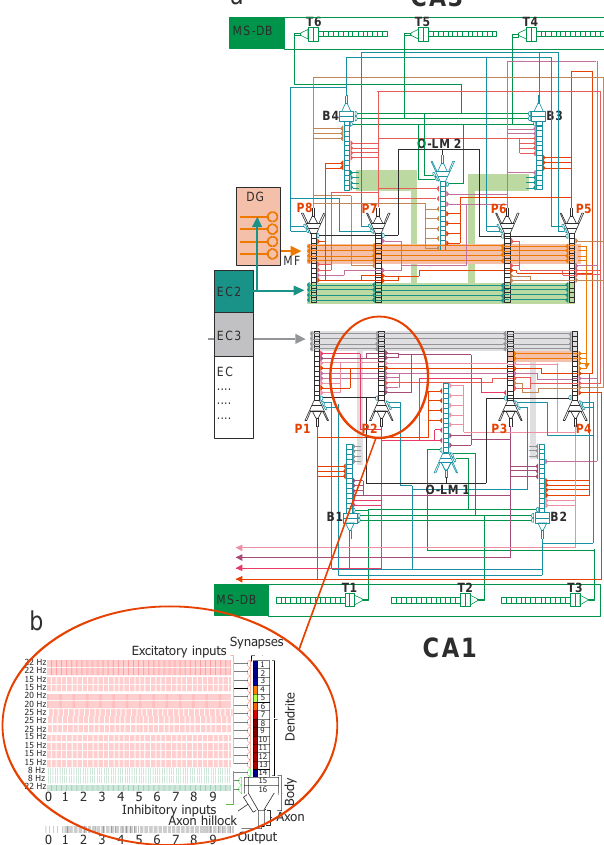
Figure 1. ( a ) The CA3-CA1 hippocampal formation microcircuit. On the top is the CA3 region and CA1 is at the bottom. Major cell types and their connectivity: pyramidal (P1–P8), basket (B1–B4), OL-M (1–2) cells, mossy cell (MC). T1–T6 represent GABAergic cells in the medial septum-diagonal band (MS-DB) region. Every CA1, CA3 pyramidal cells, basket and O-LM cells consist of 16 compartments in which each dendrite has an excitatory or inhibitory synapse (example–pyramidal cell on the left at bottom). ( b ) Example–pyramidal cell. Red excitatory, green inhibitory inputs. Pyramidal cell model configuration with color filled postsynaptic regions according to values of LTP at the end of